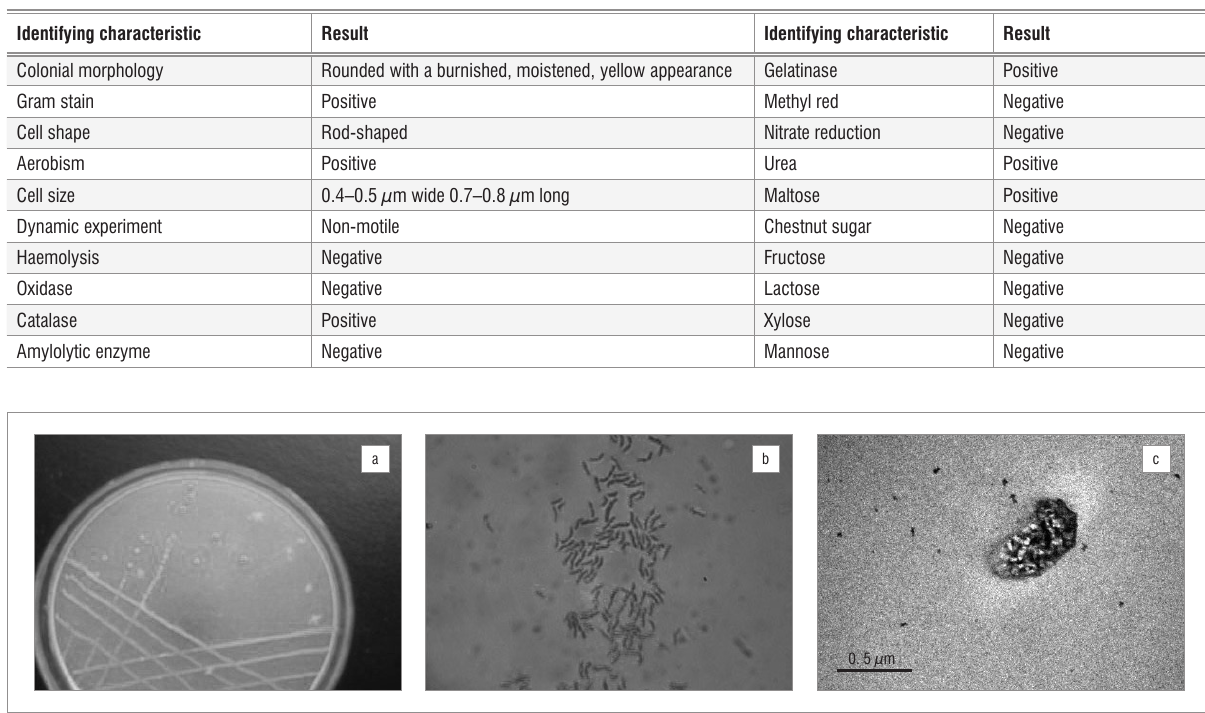
The morphology of Arthrobacter sp.0574. (a) Colonial morphology, (b) a light micrograph of Arthrobacter sp.0574 (1000×) and (c) an electron micrograph of Arthrobacter